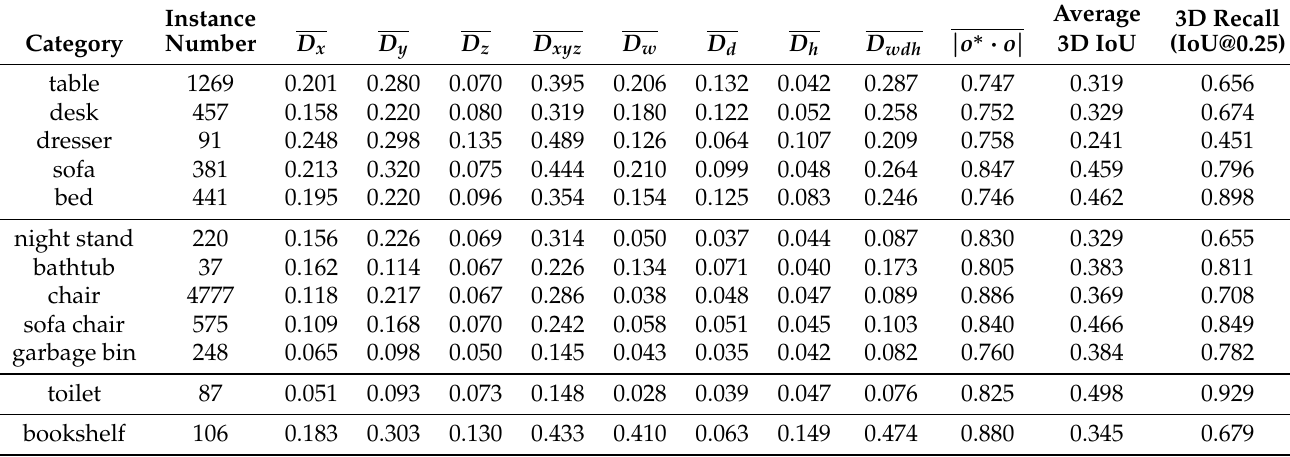
Table 8. Detailed evaluation results. Frustum VoxNet is evaluated based on SUN RGB-D validation set. Frustums used to finalize detection are generated from ground truth 2D bounding boxes. The 3D IoU threshold used for 3D recall is 0.25.